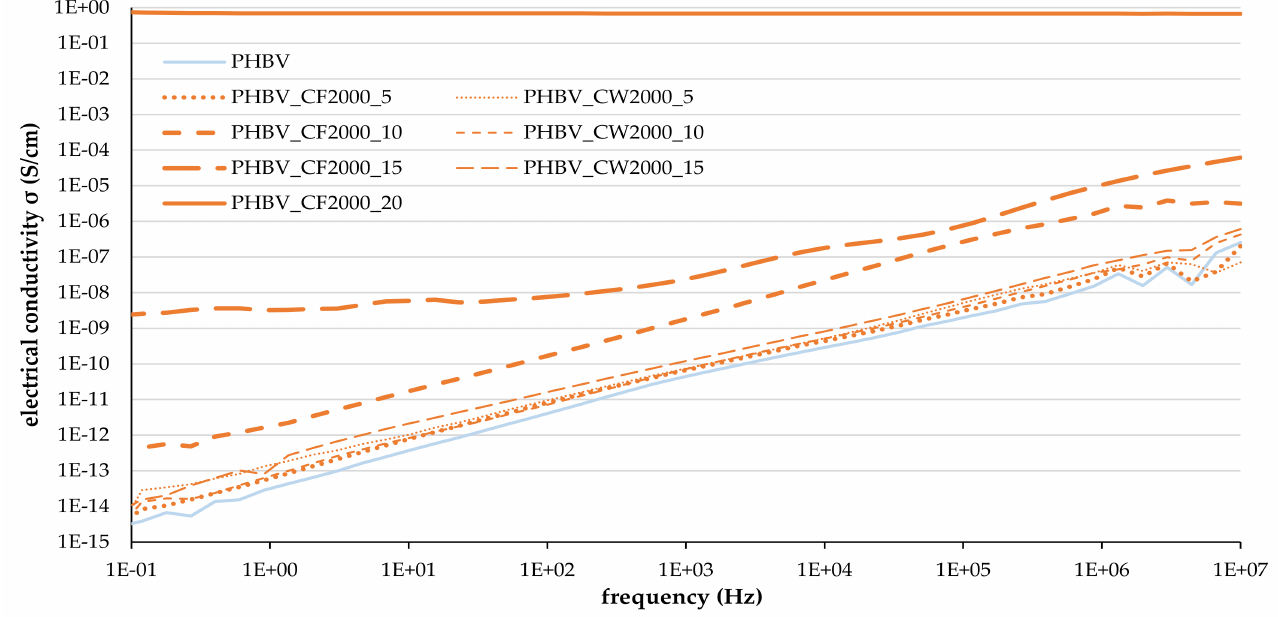
Figure 4. Electrical conductivity of PHBV composites in the measured frequency range. Impact of filler content (5–20 vol.%) and filler type (carbonized cellulose fibers (CF) or wood dust